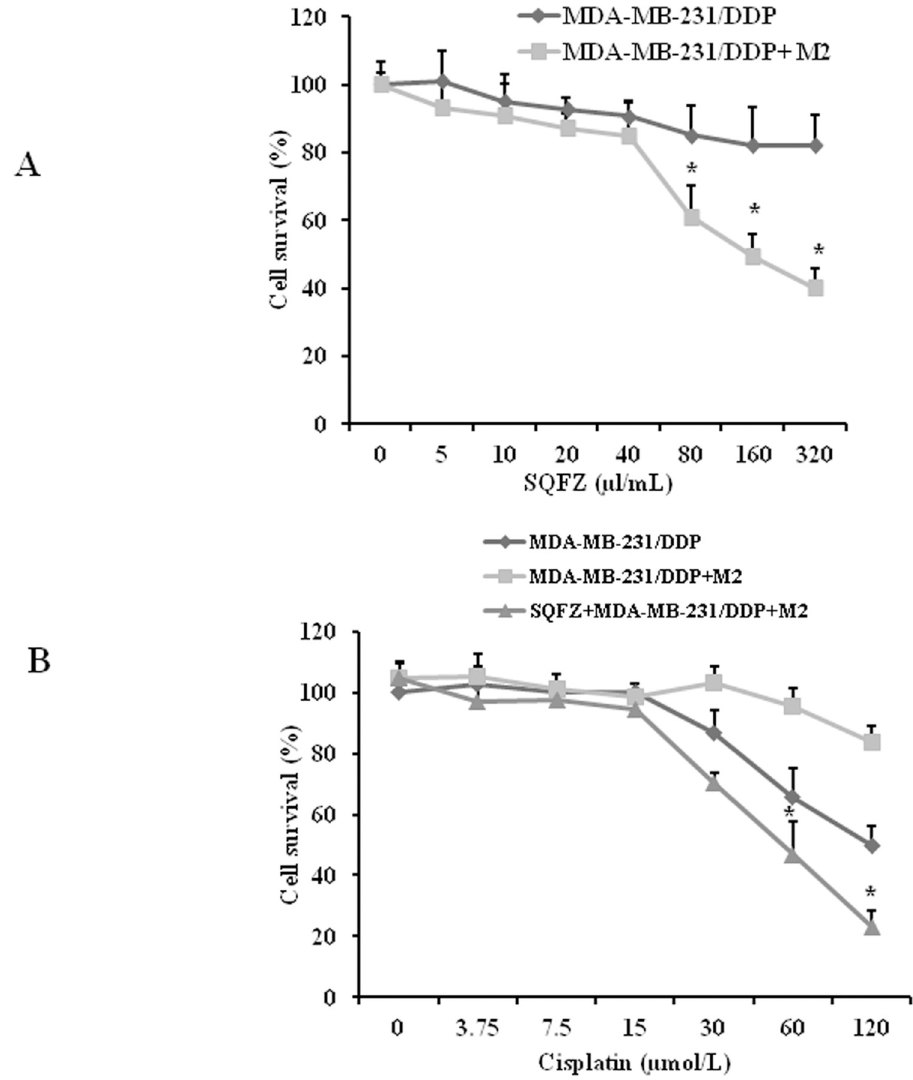
Fig 5. Sensitivities of MDA-MB-231/DDP cells to SQFZ and SQFZ + Cisplatin. (A) Both MDA-MB-231/DDP and MDA-MB-231/DDP co-cultured with M2-macrophage cells were incubated in SQFZ at 5, 10, 20, 40, 80, 160, or 320 μ l/ mL for 48 h. (B) MDA-MB-231/DDP and MDA-MB-231/DDP+M2 were treated with cisplatin at 3.75, 7.5, 15, 30, 60, or 120 μ mol/L with or without SQFZ (40 μ l/mL) for 48 h. Values are shown as the means ± SD from three independent experiments. � p < 0.05 as compared to Cisplatin